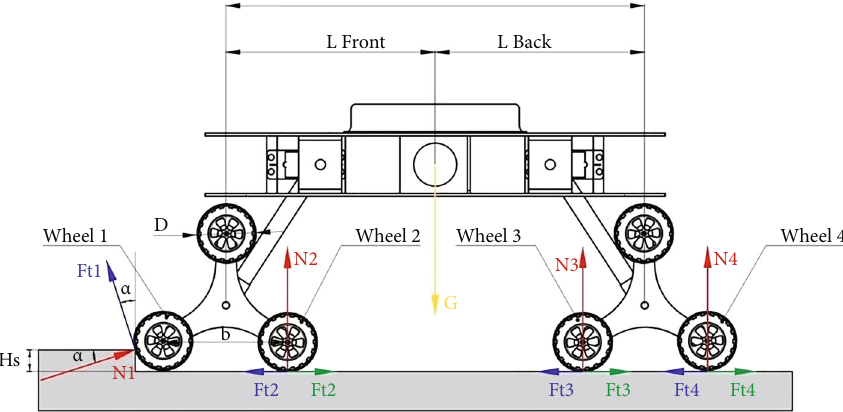
Figure 4: Mechanical model of the two front planetary wheels at the same time in the case of vertical obstacle